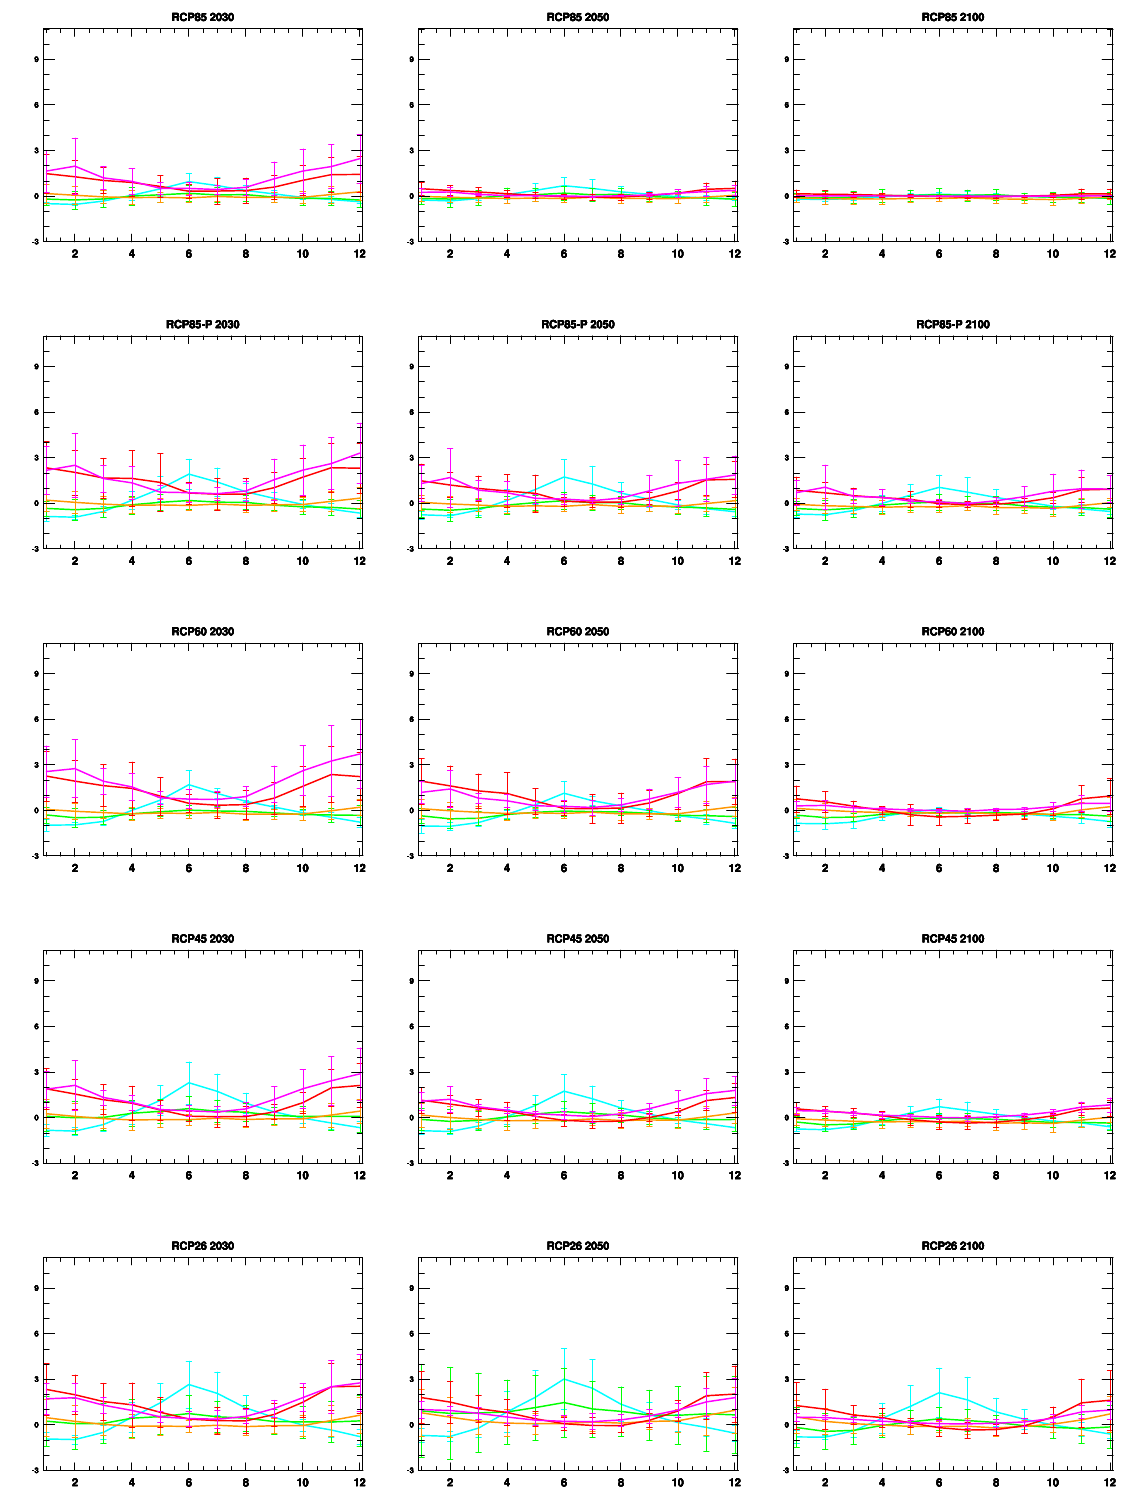
Fig. 8. Percentage change in surface ozone in megacity grid cells when megacity emissions are reduced by 25% and redistributed throughout the host countries. Left to right: years 2030; 2050; and 2100. Top to bottom: RCP-8.5; RCP-8.5-P; RCP-6.0; RCP-4.5; and RCP-2.6. Lines for each latitude band are coloured as in Fig. 6.